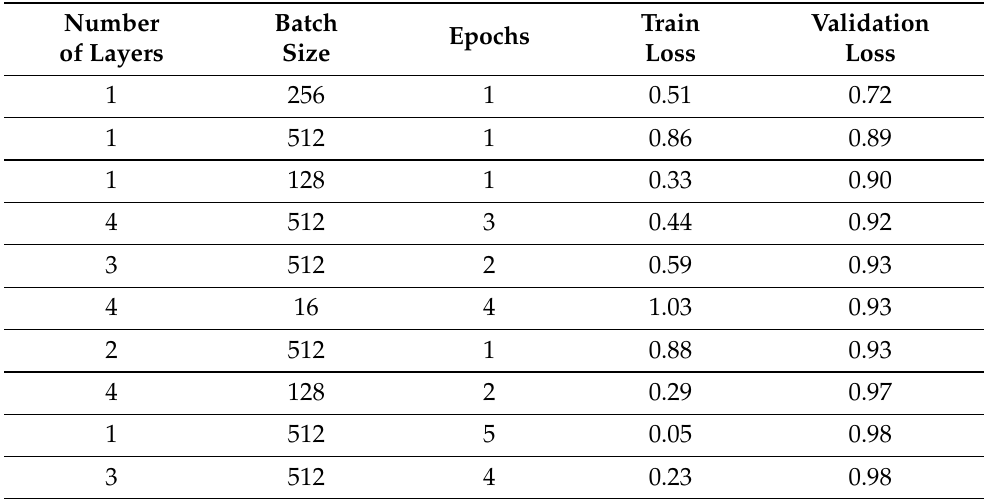
Table 15. Parameter configuration and model loss for the training and validation